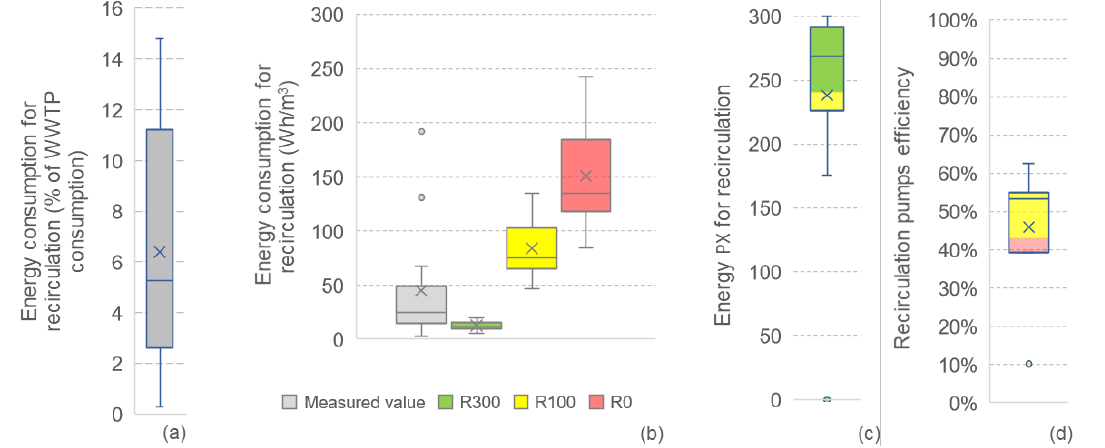
Figure 8. The energy consumption for recirculation in the iEQTA WWTPs (% ( a ) and Wh/m 3 ( b )), the computed reference values ( b ), the performance indices ( c ), and the pumps efficiency ( d ).